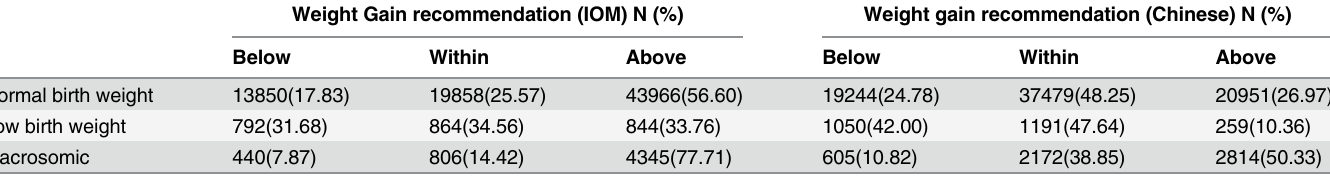
Table 6. Cross table of weight gain by IOM and